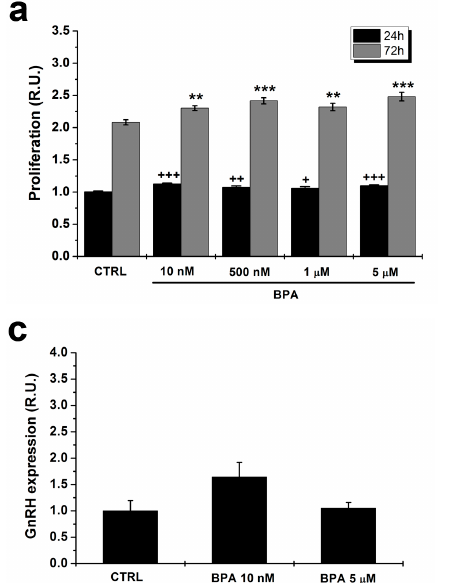
Figure 1. Effects of BPA concentrations in the nM– μ M range on proliferation and survival of GT1–7 cells. ( a ) BPA induced a limited but statistically significant increase in cell proliferation in a concentration ‐ independent way, at both 24 and 72 h. ANOVA and Dunnett’s post hoc test; * p < 0.05, ** p < 0.01, *** p < 0.001 for each BPA dose vs. control condition (CTRL) at 24 h; + p < 0.05, ++ p < 0.01, +++ p < 0.001 for each BPA dose vs. CTRL at 72 h. ( b ) The same concentration range had no effect on cell survival at 24 h (ANOVA and Dunnett’s post hoc test). ( c ) At both 10 nM and 5 μ M, BPA did not